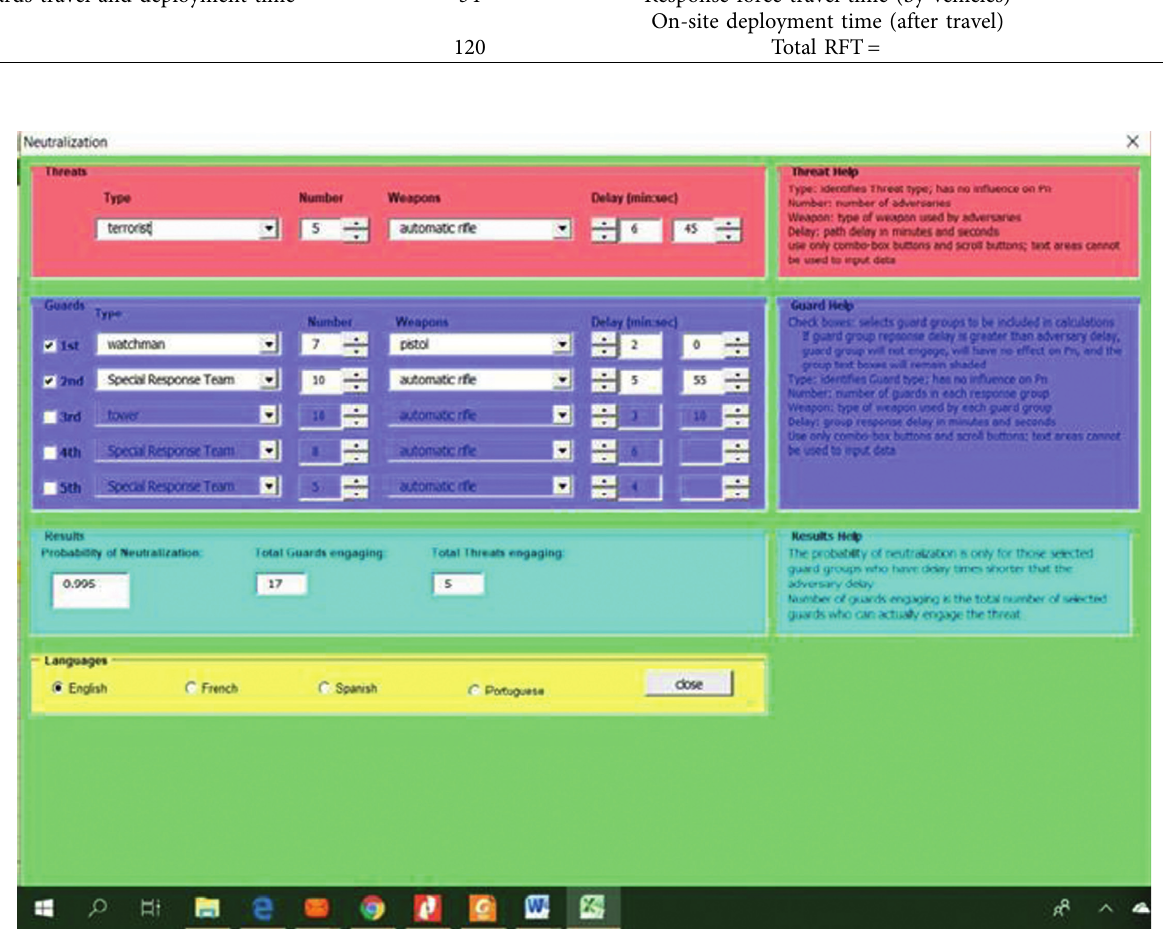
Figure 6: ASSESS code calculation results for the probability of neutralization P categories and numbers. The resulting value of P N �